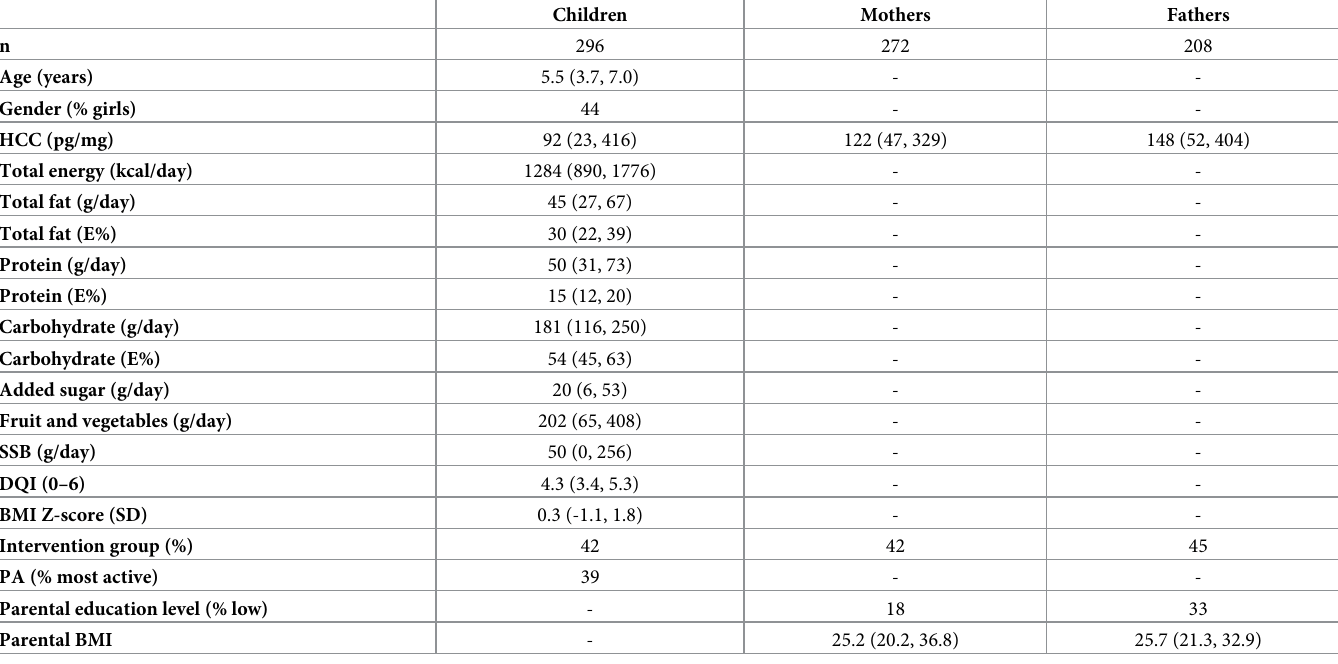
Table 1. Study characteristics of children and parents. Results presented as median and 5–95 percentiles unless stated otherwise.